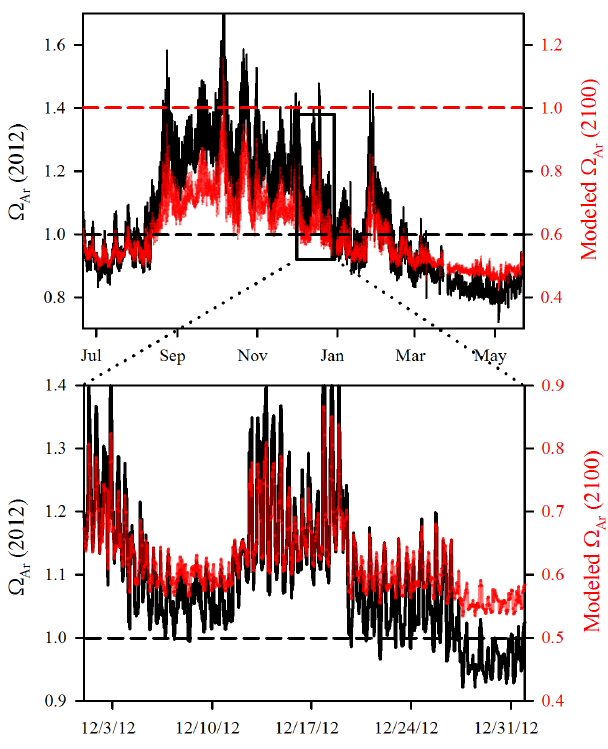
Figure 8. Observed p CO 2 in 2012 (black) and modeled p CO 2 us- ing the IPCC RCP 6.0 scenario for the year 2100 (red) at the Del Mar buoy (88m) over an annual cycle (top). A close-up for the month of December is shown in the bottom panel. Note that the range, but not the absolute values, of the vertical axes for each fig- ure is the same.